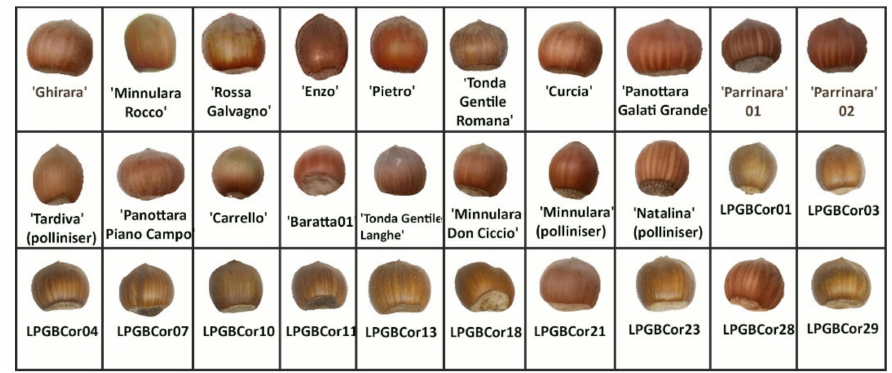
Figure 4. Nut morphology of thirteen Sicilian hazelnut genotypes collected on the Nebrodi Mountains.